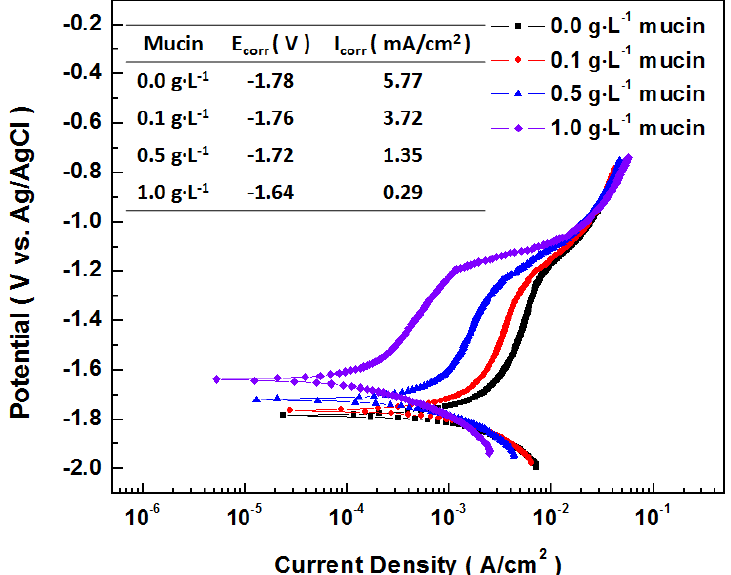
Figure 11. Potentiodynamic polarization curves for AZ31 magnesium alloy in Gamble solution (Solution #3) with different concentrations of